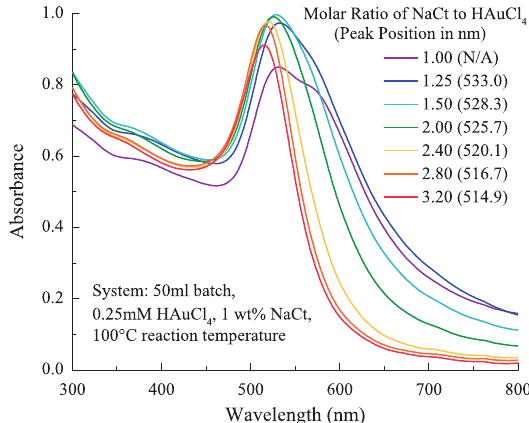
Fig. 1 The SPR peak position of AuNPs shifted to shorter wavelength and the peak width decreased as the molar ratio increased from 1.00 to